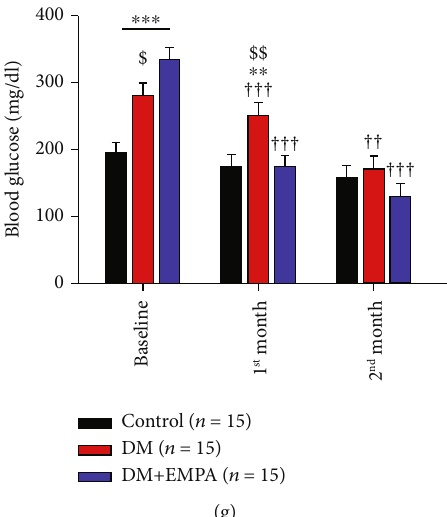
Figure 1: Mice general maintenance physiological parameters. (a) Mean weight, (b) water intake, (c) urine output, (d) urine protein exertion, (e) urine creatinine, and (f) urine glucose level. C57Bl/6 group (black columns), DM mice (red columns), and DM+EMPA (blue columns). ∗ P < 0 : 05 vs. C57Bl/6, ∗∗ P < 0 : 01 vs. C57Bl/6, ∗∗∗ P < 0 : 001 vs. C57Bl, $ P < 0 : 05 vs. DM+EMPA, $$ P < 0 : 01 vs. DM +EMPA, $$$ P < 0 : 001 vs. DM+EMPA, £££ P < 0 : 001 vs. one month, † P < 0 : 05 vs. BL, †† P < 0 : 01 vs. BL, ††† P < 0 : 001 vs. BL. (g) Mice blood glucose level. C57 group (black columns), DM mice (red columns), and DM+EMPA (blue columns). ∗∗ P < 0 : 01 vs. C57, ∗∗∗ P < 0 : 001 vs. C57, $ P < 0 : 05 vs. DM+EMPA, $$ P < 0 : 01 vs. DM+EMPA, †† P < 0 : 01 vs. BL, ††† P < 0 : 001 vs. BL. Data represent the mean ± SEM